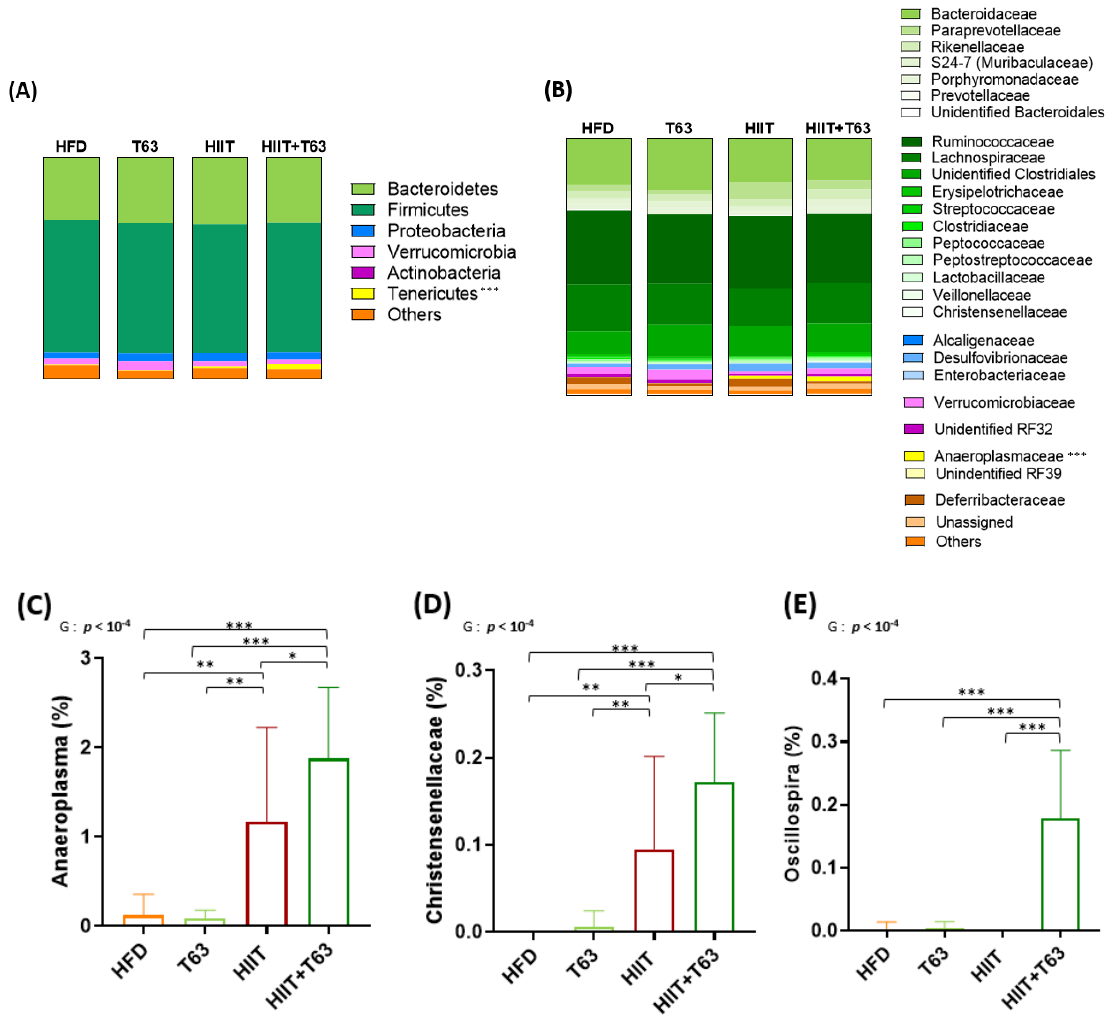
Figure 8. Taxonomy at the phylum ( A ) and family ( B ) levels for the four groups. Relative abundance (%) of specific bacterial types in the mucosa-associated microbiota at the end of the 12-week intervention ( C – E ) * p < 0.05, ** p < 0.005, *** p < 0.0005, G: group